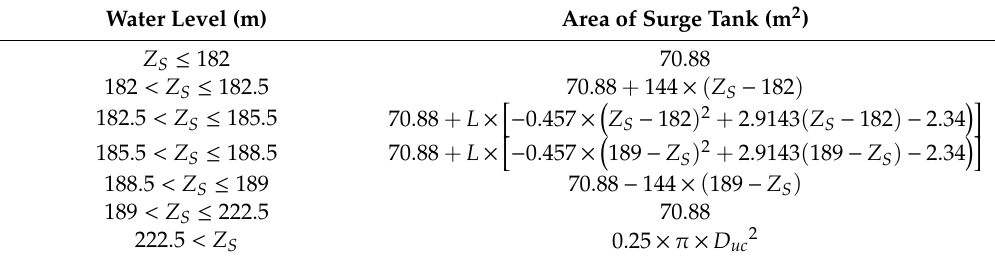
Table 2. Variation in area of the surge tank.